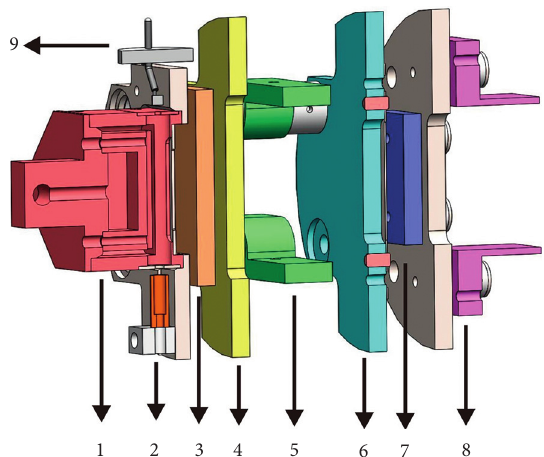
Figure 3: Main composition of the designed EI ionization